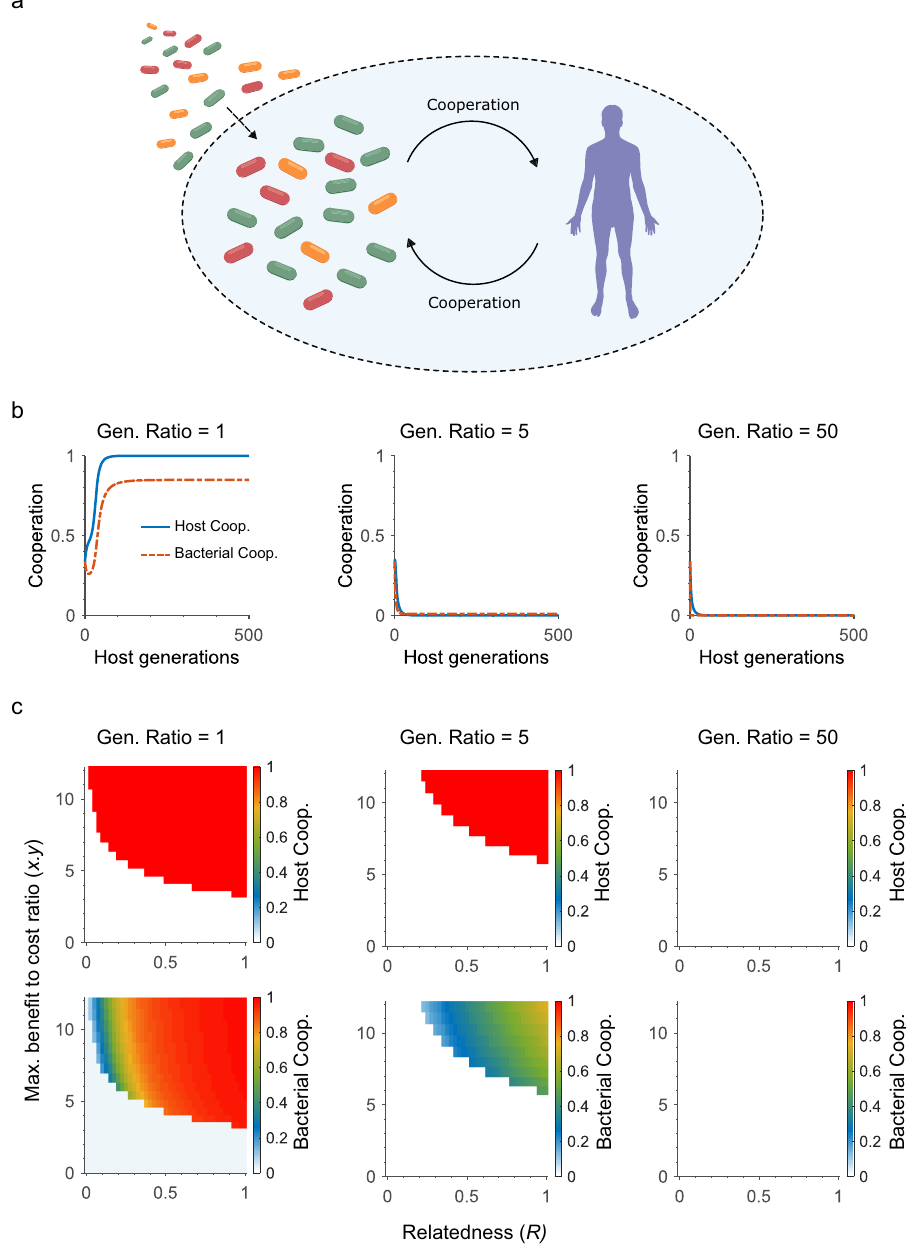
Fig. 1 Cooperation breaks down in diverse and long-lived microbiomes. a Cartoon of the model: Both hosts and microbiota can invest in cooperation. Host can also invest in host control that preferentially bene fi ts more cooperative symbionts. Microbes migrate into the system at rate M from a fi xed environmental pool of largely uncooperative microbes between host generations, and at rate m each symbiont generation within host generations (Methods, Table 1). b Example dynamics from the model. Cooperation evolves when the bene fi ts of cooperation are high, symbiont relatedness is high (i.e. within- species diversity is low) and the microbiome is short lived (the ratio of symbiont to host generations is 1). Increasing the number of symbiont generations within a single host generation (generation ratio) increases symbiont competition within the host and cooperation with the host collapses (unless stated, parameters are x = y = 2, R = 0.5, f = 0.02, g = 0.1, m = 1× 10 − 6 , M = 0.05). c Effect of relatedness and bene fi t to cost ratio of the evolution of cooperation. Cooperation is only stable at high relatedness, high bene fi t to cost ratio and low generation ratio. Increasing the generation ratio leads to the collapse of cooperation across a wide parameter